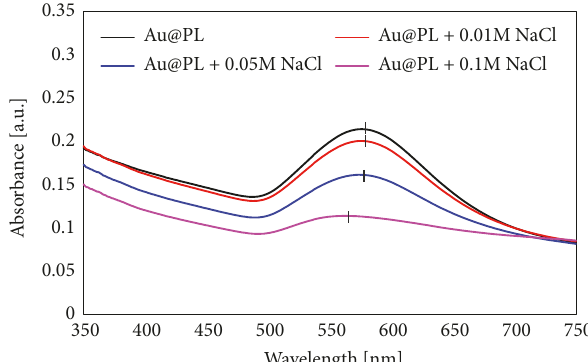
Figure 1: UV-vis spectra and of Au@PL with addition of NaCl in different concentration.